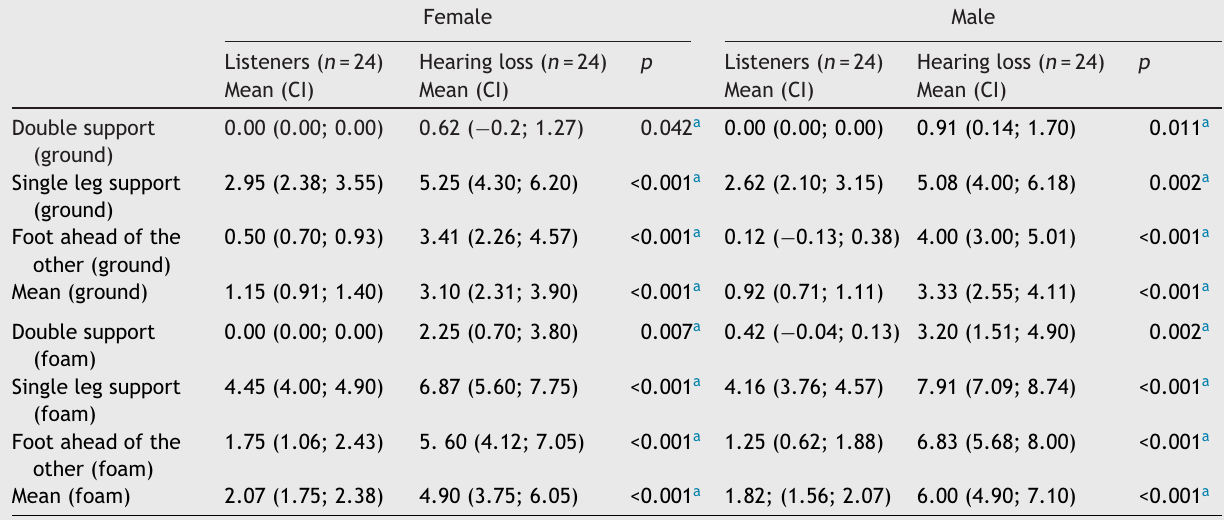
Mean and confidence interval values for performance of postural control of students listeners and with sensorineural hearing loss according to gender ( n =